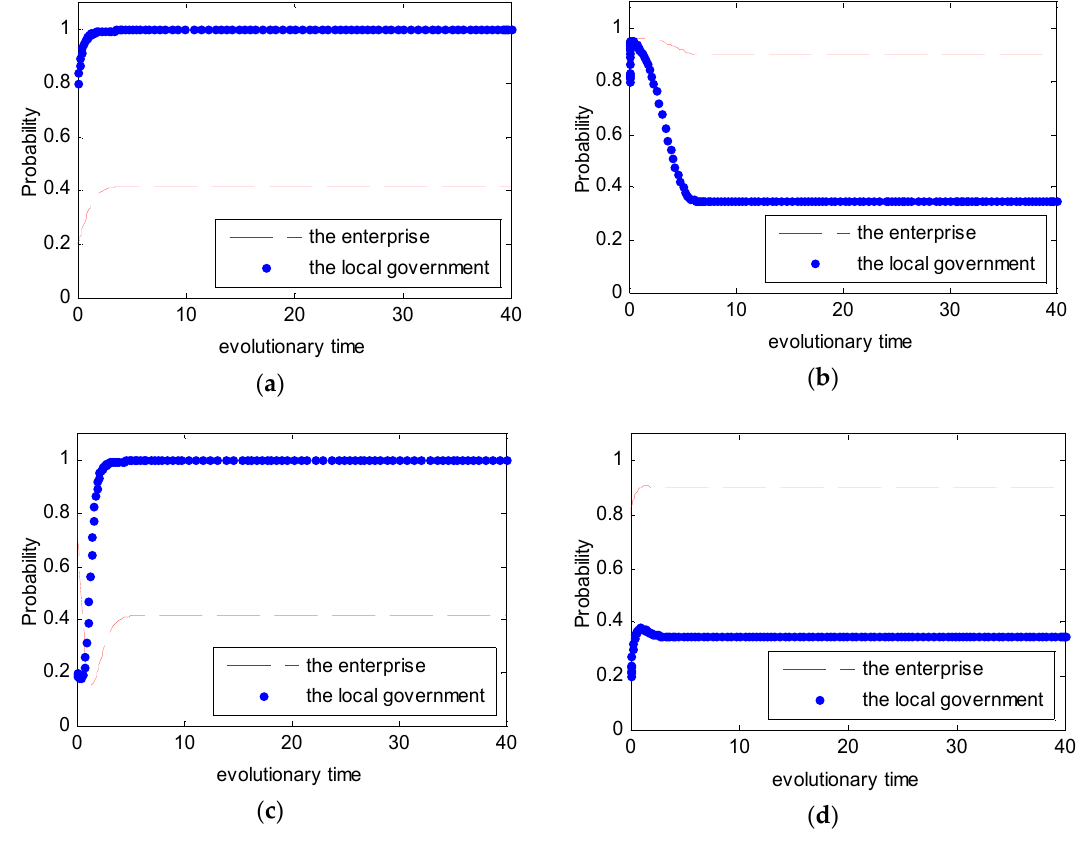
Figure 10. Probability of choosing a strong willingness strategy for di ff erent time t. ( a ) p t ( 0 ) = 0.2, q t ( 0 ) = 0.8, f m = 6; ( b ) p t ( 0 ) = 0.2, q t ( 0 ) = 0.8, f m = 6; ( c ) p t ( 0 ) = 0.8, q t ( 0 ) = 0.2, f m = 100; and ( d ) p t ( 0 ) = 0.8, q t ( 0 ) = 0.2, f m =